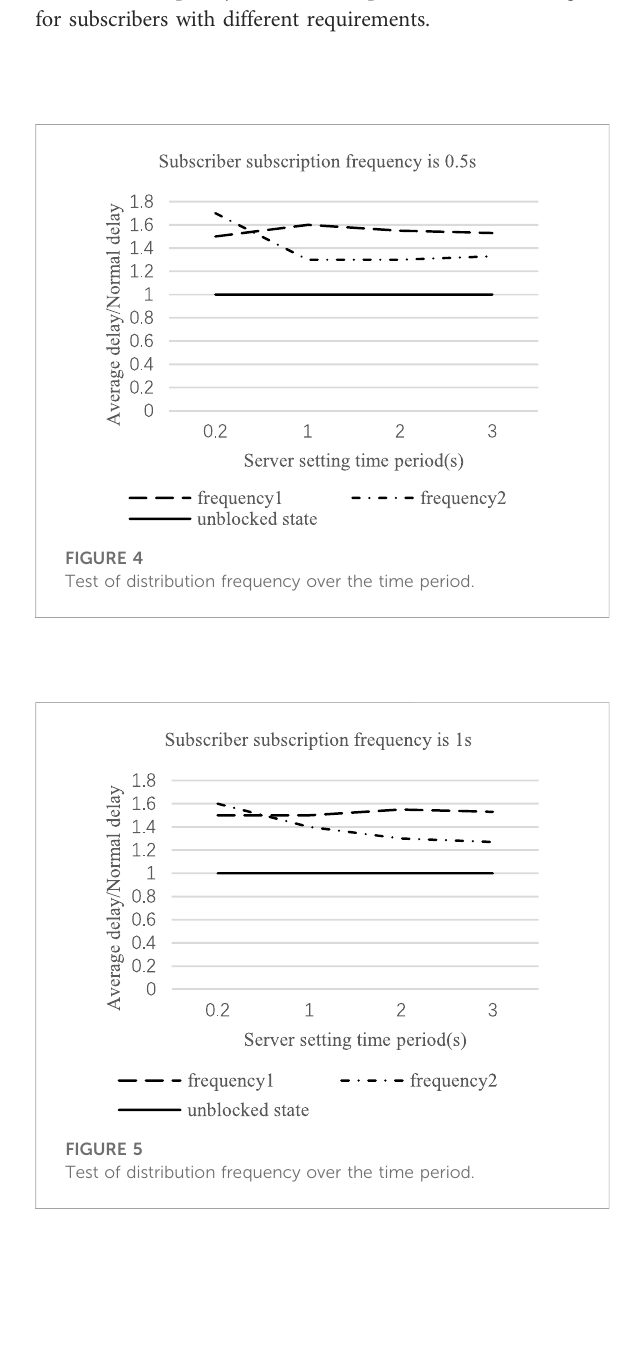
FIGURE 3 Experimental results ii effect of time period on